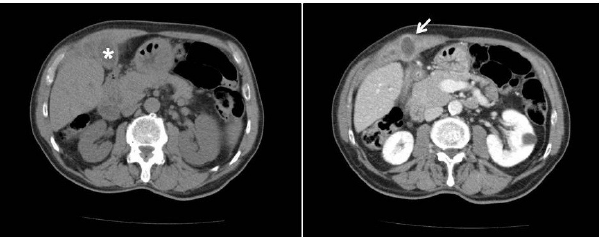
Figure 2. Abdominal computed tomography images. Left image, * indicates the gallbladder; right image, the arrows indicates the fistula.